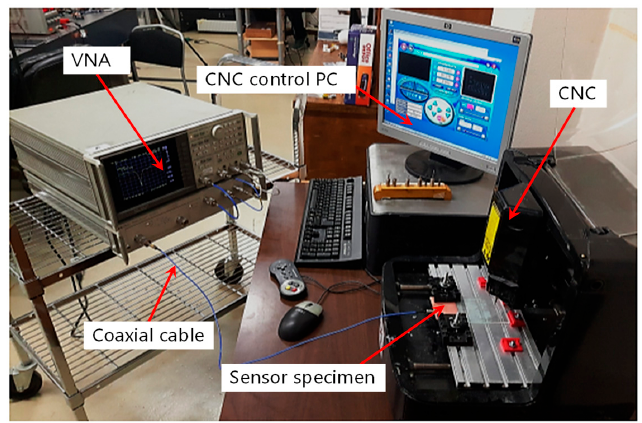
Figure 11. Experiment setup.